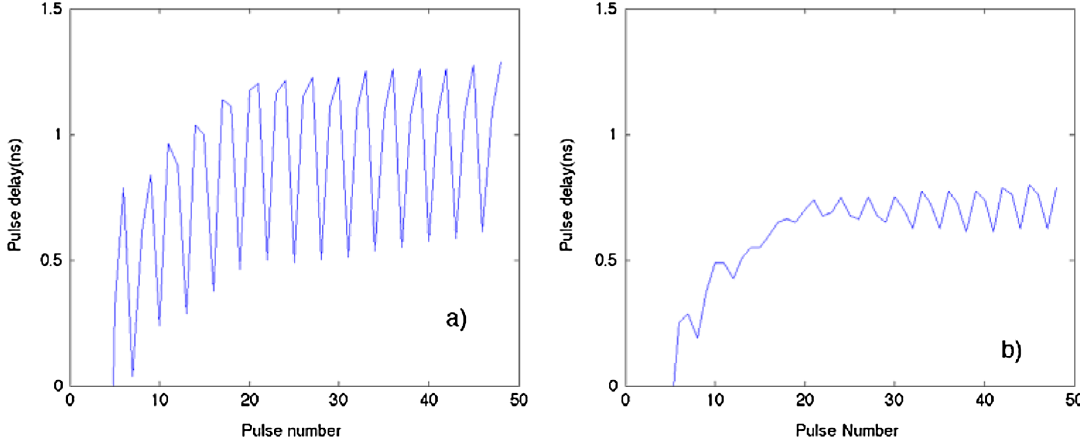
FIG. 10. (a) Time delay from the reference timing as a function of the pulse number. (b) Compensated time delay from the reference timing as a function of the pulse